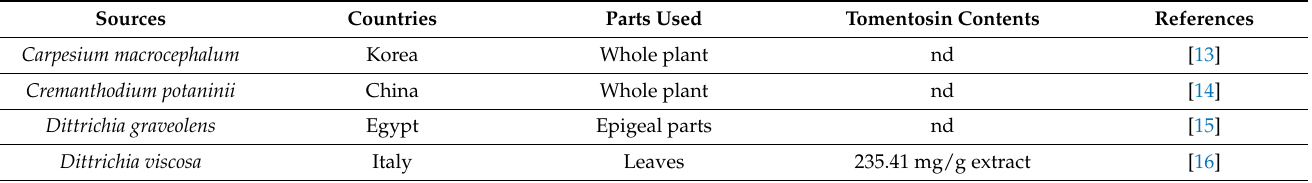
Table 1. Biological sources of